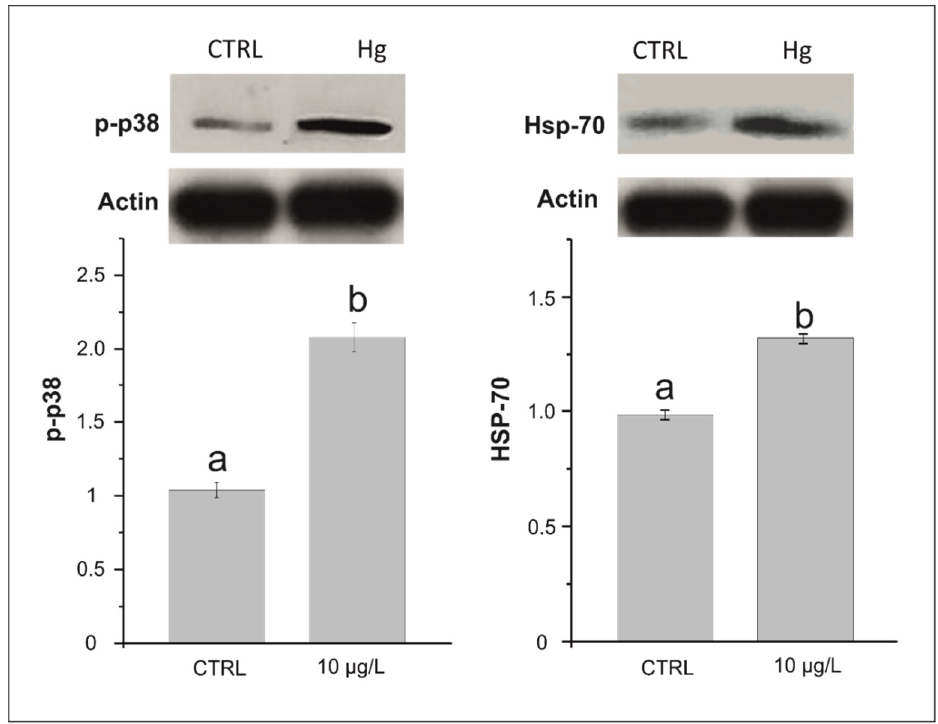
Figure 2. Levels of HSP-70 and p-p38 in the symbiont-bearing foraminiferal species Amphistegina lessonii in samples exposed for 24 h at 10 µg/L of Hg and control samples (no added Hg). Data are reported as mean ± standard deviation ( n = 5). Letters denote significant differences ( p < 0.01) between groups.